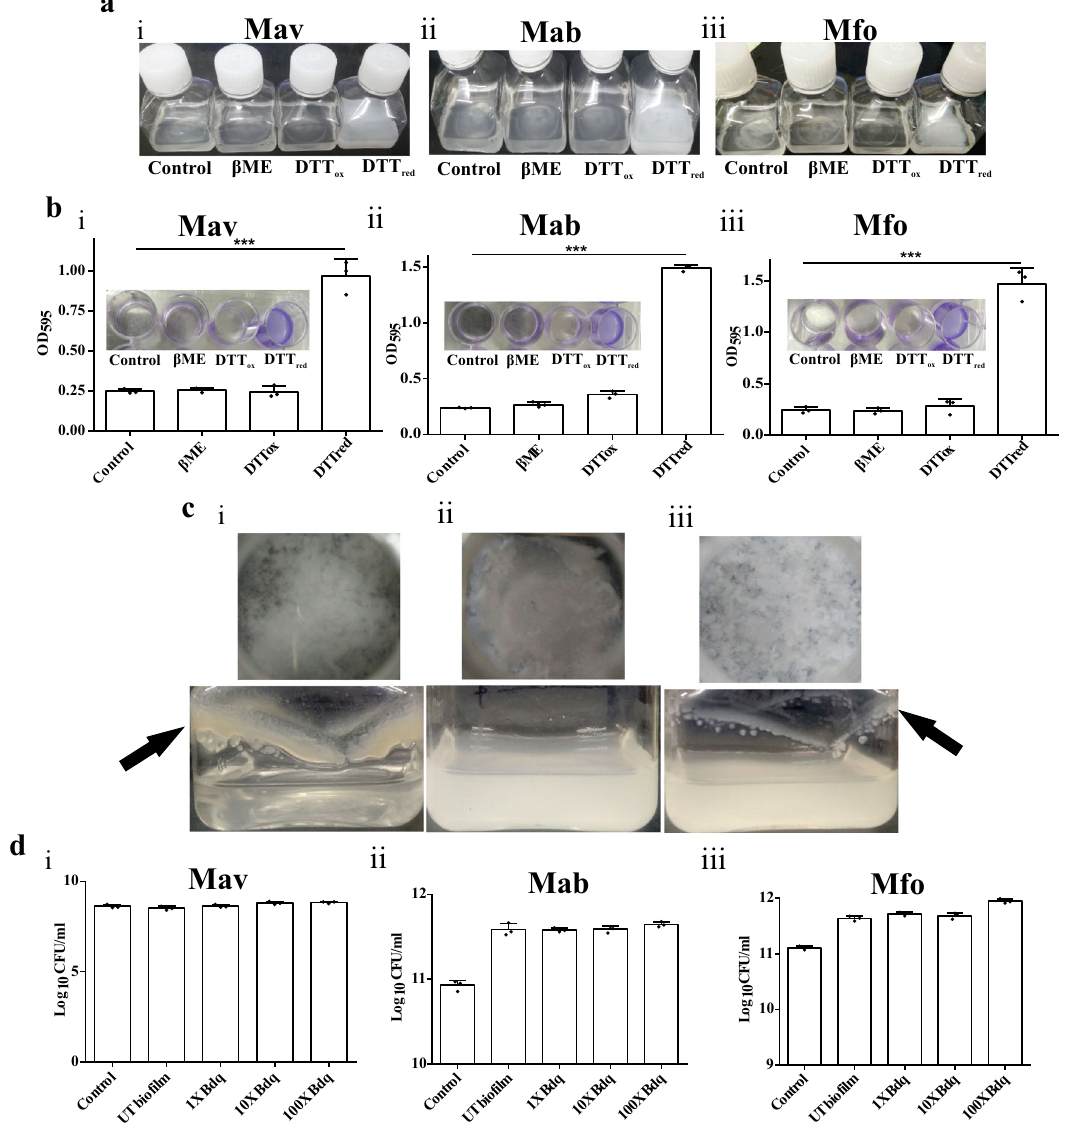
Fig. 1 Thiol reductive stress leads to drug-tolerant bio fi lm formation in NTMs. a Exponential cultures of Mav ( i ), Mab ( ii ) and Mfo ( iii ) were exposed to 6 mM of β ME, oxidized, or reduced DTT individually. Only exposure to reduced DTT resulted in bio fi lm formation. b Cultures of Mav, Mab, and Mfo were exposed to 6 mM of DTT to induce bio fi lm formation. CV assays were performed to quantitate Mav ( i ), Mab ( ii ), and Mfo ( iii ) bio fi lms. c Thiol reductive stress-induced submerged bio fi lm of Mav ( i ), Mab ( ii ) and Mfo ( iii ) in standing culture (upper panel) and under slow shaking (lower panel). Bio fi lms formed are indicated with black arrows. d Colony forming units of Mav ( i ), Mab ( ii ) and Mfo ( iii ) were estimated after treatment with 1×, 10× and 100× MIC of Bedaquiline by degrading the bio fi lms of the NTMs using cellulase and plating them on 7H11 agar after serially diluting them. The column bar graphs were plotted using GraphPad Prism 6 and represented as mean (±s.e.m). Statistical signi fi cance was determined using Student ’ s t -test (two tailed). For b ( i ), ( ii ) and ( iii ), *** P = 0.0003, *** P < 0.0001 and *** P = 0.0002 respectively. All data are representative of three independent biological experiments performed in triplicates. All source data are provided as a Source Data fi signi fi cant component of the pellicle bio fi lms of Mtb 11 , while we have observed that TRS induced Mtb bio fi lms are rich in poly- saccharides 17 . However, the biochemical nature of EPS of the NTM bio fi lms remains poorly characterized. In an effort to understand the nature of EPS in NTM bio fi lms, we analyzed EPS of NTM colonies through plating on media containing Congo Red (CR) and Coomassie Brilliant Blue (CBB) 25 . CR could label large complexes like cellulose or amyloid structures, while CBB stains proteins in the colony bio fi lms. We observed that NTM colonies take up CR on the 7H11 plates, suggesting the presence of a polysaccharide-rich or amyloid-rich EPS (Supplementary Fig. 4a – c). We also induced